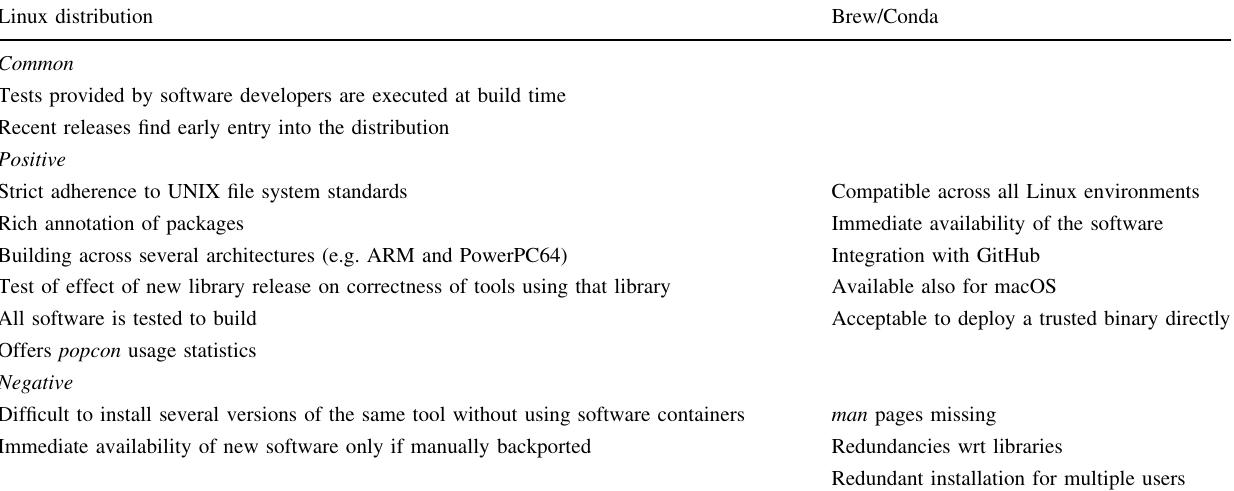
Table 1 Features in Linux distributions and cross-distribution package providers Linux